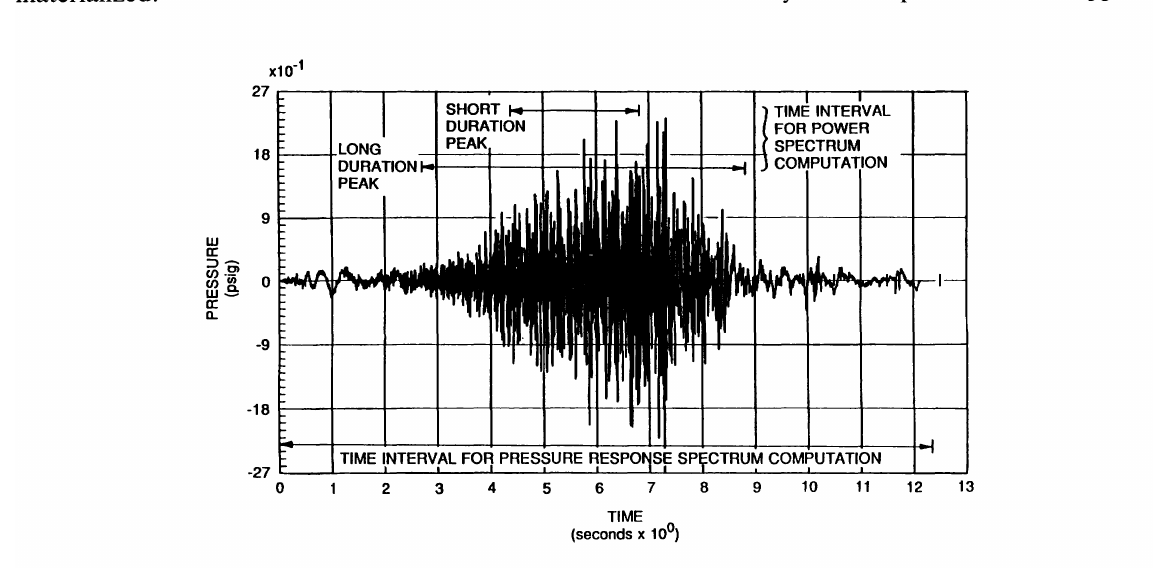
FIGURE 2 Shuttle data: short transient with random pressure